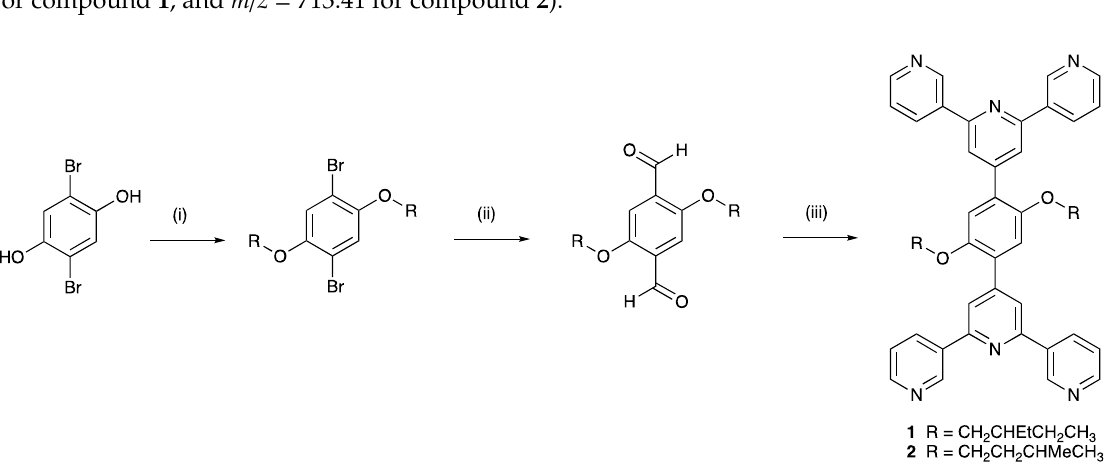
2 and are similar to that observed